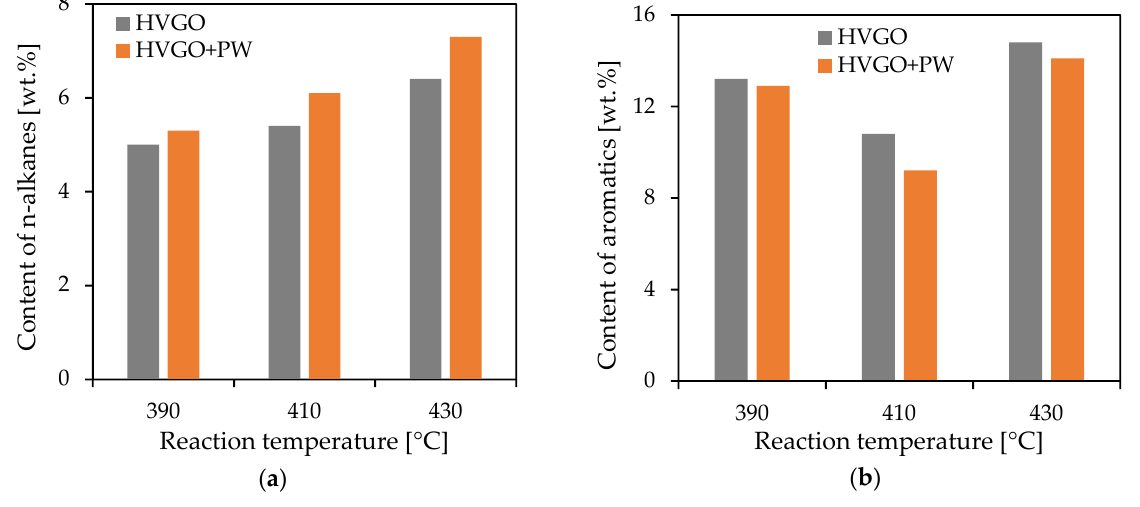
Figure 4. Group-type composition ( n -alkanes ( a ) and aromatics ( b )) of middle distillates obtained by hydrocracking of HVGO and HVGO containing 10 wt.% of petroleum wax (HVGO + PW) at various temperatures.